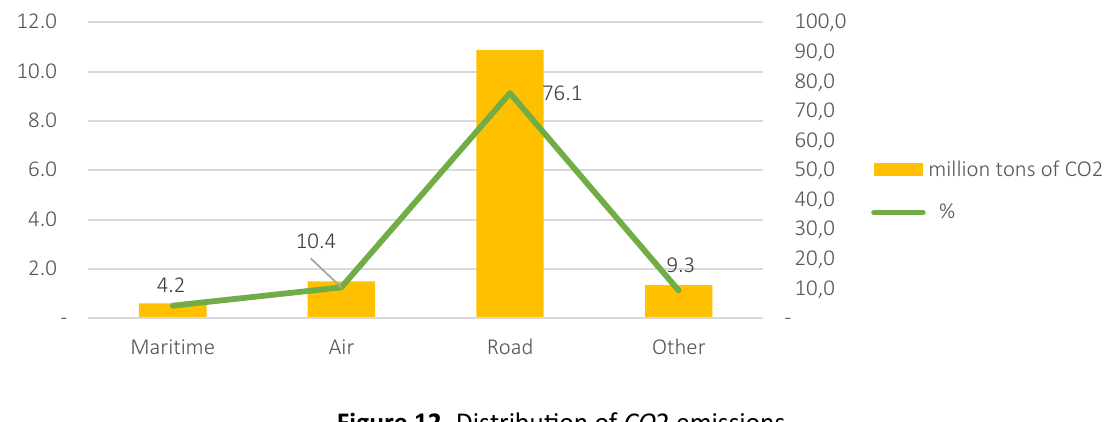
Figure 12. Distribution of CO 2